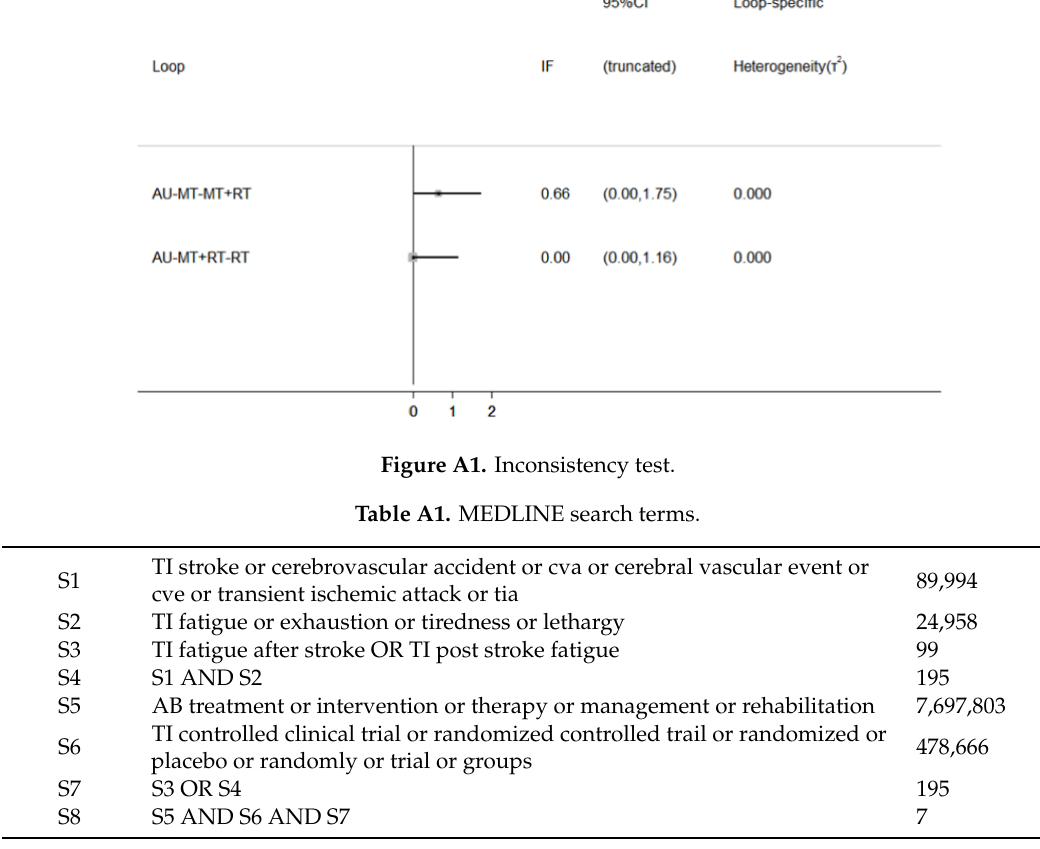
Table A2. Characteristics of all involved studies.